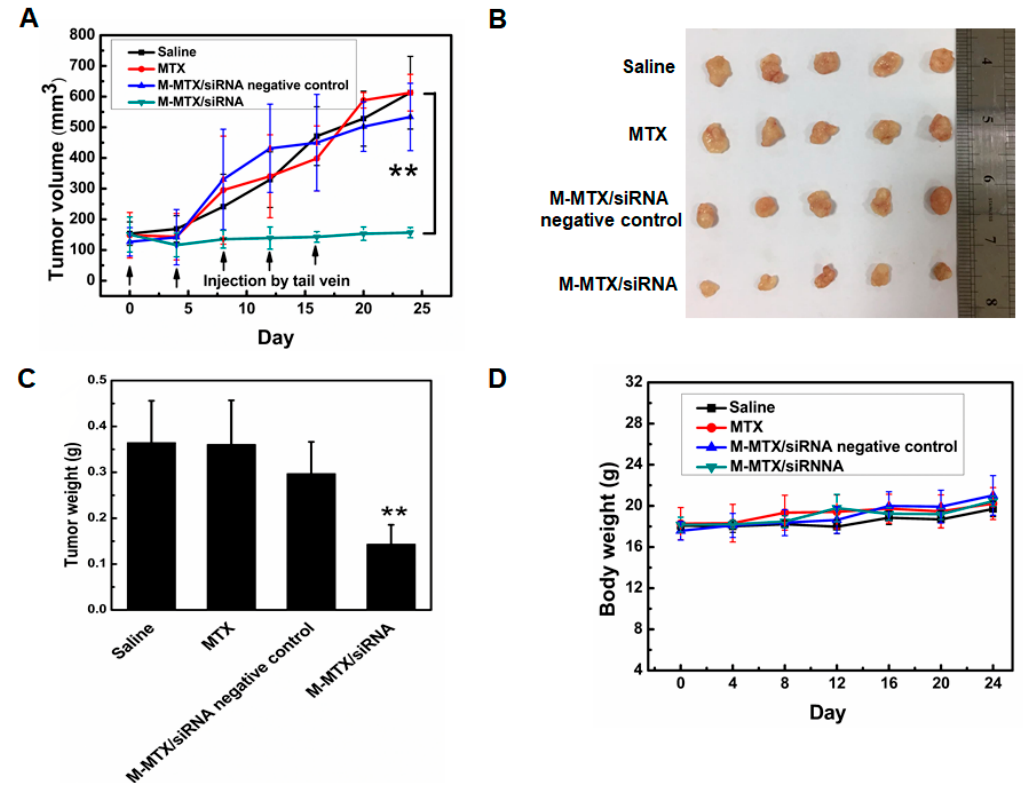
Figure 6. The therapeutic efficacy of M-MTX/siRNA in vivo. The tumor volume ( A ), photographs of the solid tumor ( B ), the tumor weight ( C ) of the animals treated with various drug formulations were obtained on day 24. (n = 5, **P < 0.01, M-MTX/siRNA compared to saline). The body weight of the tumor-bearing mice treated with various drug formulations was also measured to assess the system toxicity ( D ). The values are the mean ± SEM, n = 5.